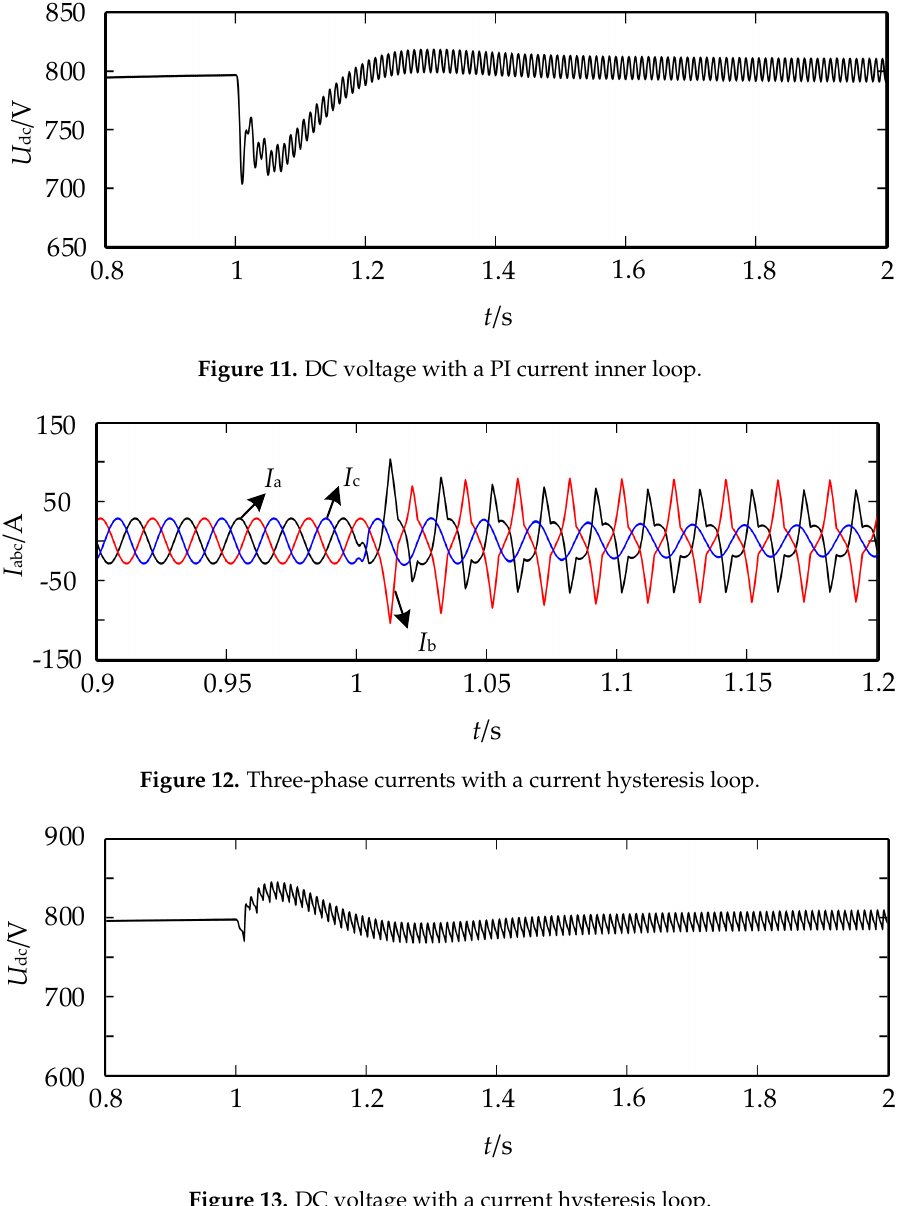
Figure 13. DC voltage with a current hysteresis loop.